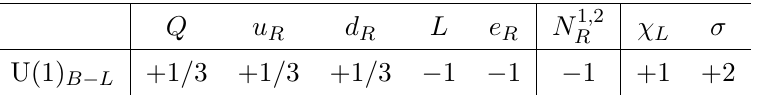
is a fermionic DM L